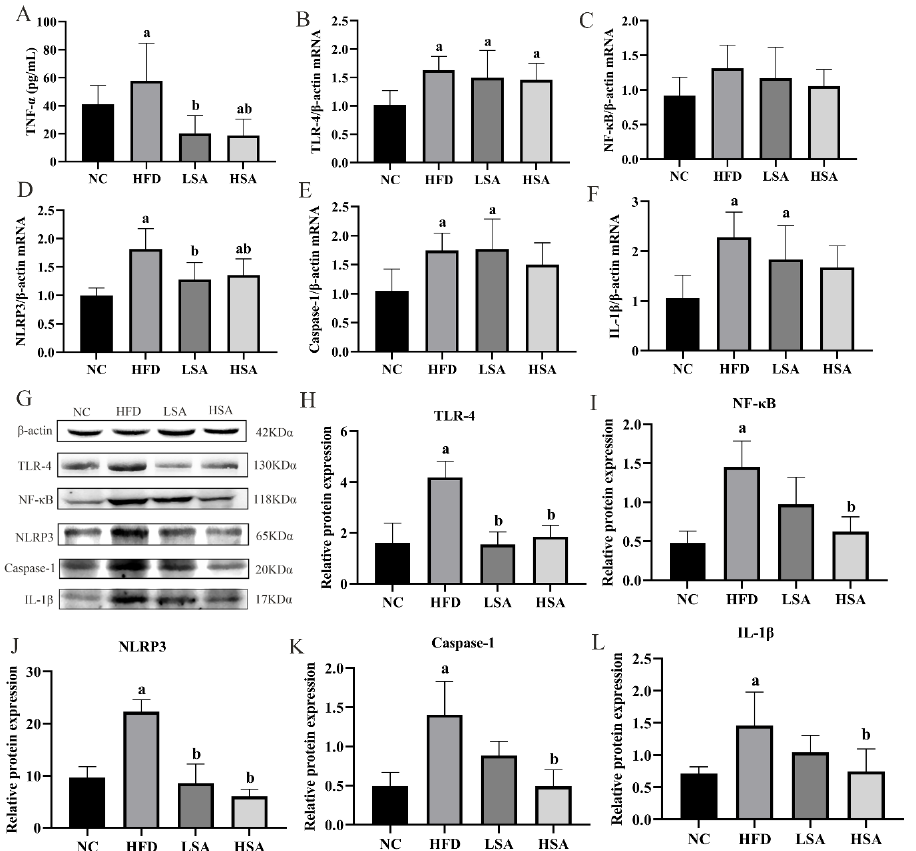
Figure 3. SA supplementation inhibited hepatic inflammation. ( A ) Serum TNF- α , n = 8 each group; ( B – F ) relative mRNA expression of TLR-4, NF- κB , NLRP3, caspase-1 and IL- 1β , n = 6 each group; ( G ) western blot assay of proteins in liver, n = 3 each group; ( H ) quantitative analyses of the TLR-4 protein; ( I ) quantitative analyses of the NF- κB protein; ( J ) quantitative analyses of the NLRP3 pro- tein; ( K ) quantitative analyses of the caspase-1 protein; ( L ) quantitative analyses of the IL- 1β protein. a p < 0.05, compared to the NC group; b p < 0.05, compared to the HFD group.